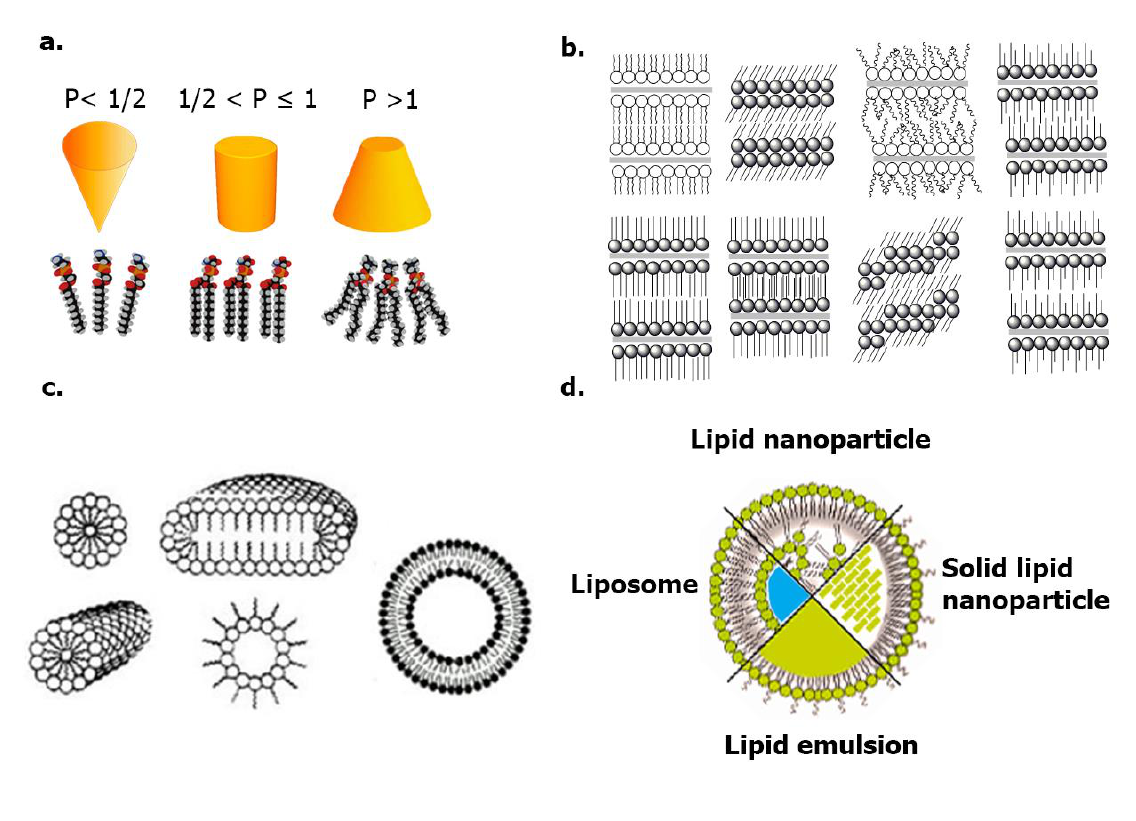
Figure 2: a. Lipid packing parameters and phases (micellar, bilayer, hexagonal); b. Varieties of lipid phases (lamellar, sub-gel, gel, liquid crystalline, etc.); c . Lipid self-assembly aggregates (Koynova and Caffrey, 1998); d. Lipid nanocarriers for